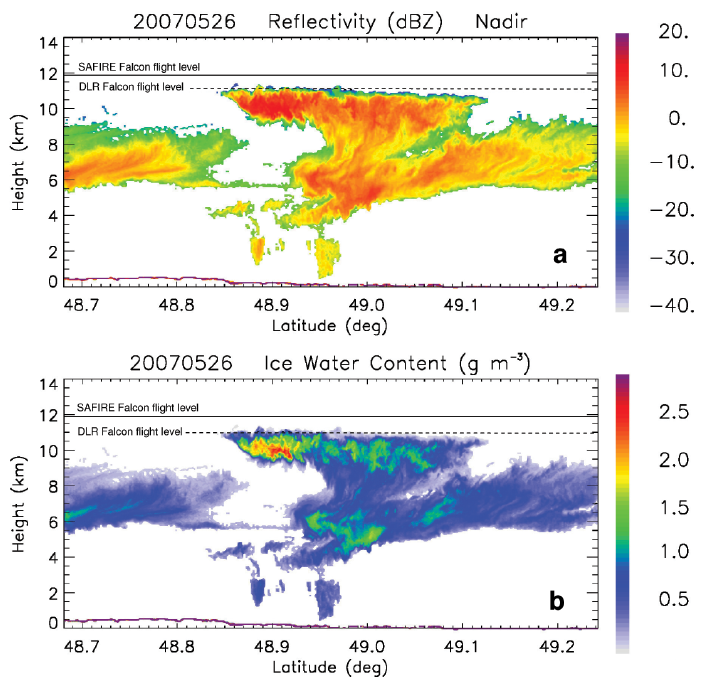
Fig. 5. Airborne RASTA radar observations along the SAFIRE aircraft trajectory at 12:57UT. (a) : Vertical profile of the equivalent reflec- tivity at 95GHz and (b) : Vertical profile of the retrieved ice water content. The flight altitudes of the SAFIRE and DLR Falcon aircraft are indicated with full and dotted lines,